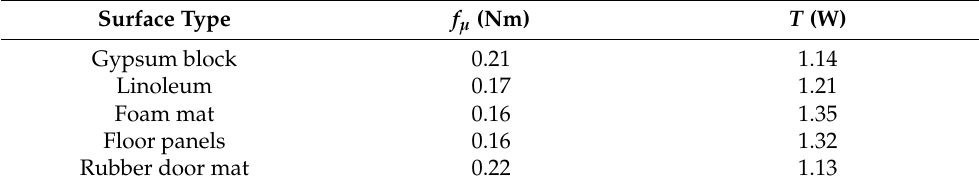
Table 3. The calculated coefficients for the differential drive mobile